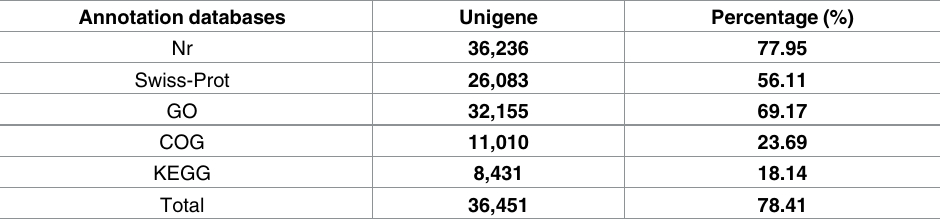
Table 1. Summary of unigene annotations within the B . humilis